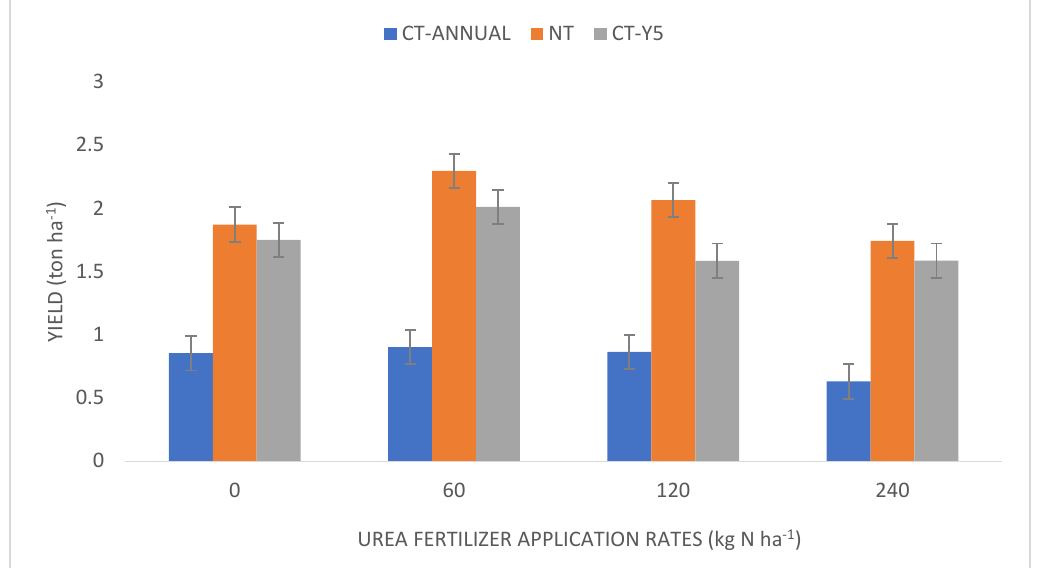
Figure 2. Maize yield of different tillage and N application treatments.